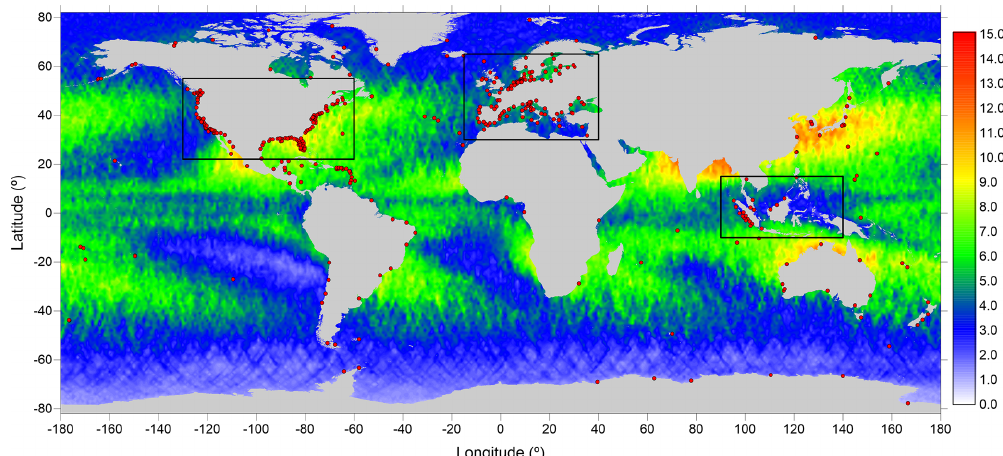
Figure 2. Location of the coastal and island GNSS stations used in GPD + (red dots). Background image shows the standard deviation of the WTC field, in centimetres, computed using ERA-Interim extracted for Envisat along-track points for the period November 2010– November 2011 (cycles 96 to 108). The black rectangles show the regions selected to perform the coastal assessment of the GPD + WTCs (the North American and European coasts and the Indonesia region).